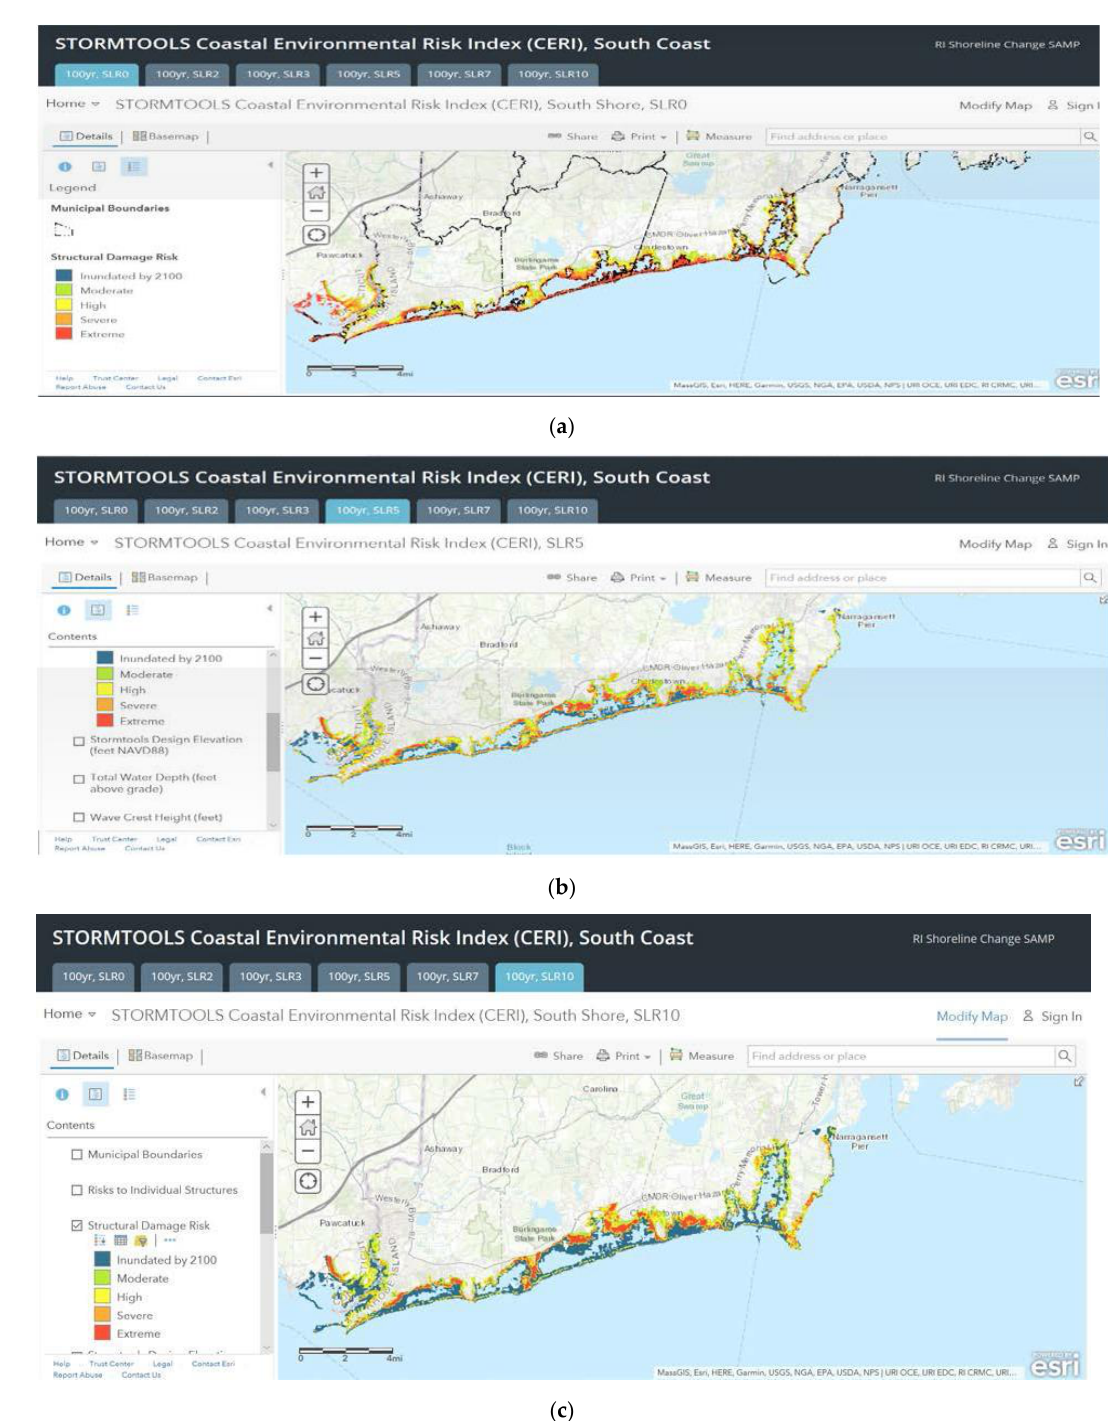
Figure 12. CERI predicted risk maps for 100 yr surge and varying SLR cases, ( a ) none (upper panel), ( b ) 5 ft (center panel), and ( c ) 10 ft (lower panel) for the Southern RI shoreline. Figure 13 shows the CERI damage map by structure overlaid on the risk map generated by the methodology outlined above. The figure clearly shows the consistency between the two maps and that the risk map is in general more conservative than the actual damage